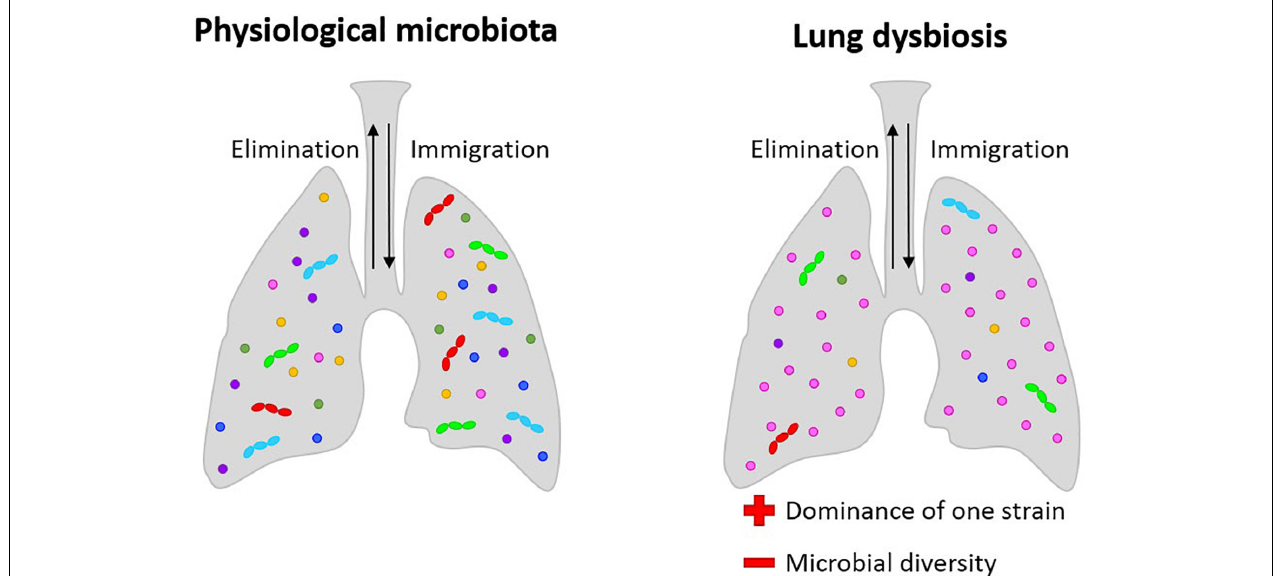
FIGURE 1 | Lung microbiota: in physiological conditions, its composition is dynamic and among the multiple bacteria present in the lungs; in pathological conditions, microbial diversity is lost, and dysbiosis situations result in both acute and chronic diseases, with the dominance of a single or a small group of taxa. In bronchiectasis, dehydrated, thickened secretions lead to endobronchial infection with a limited spectrum of distinctive bacteria, mainly Staphylococcus , Pseudomonas, and Burkholderia . In CF, the dominance of Pseudomonas aeruginosa and Burkholderia cepacea are related to the progression of the